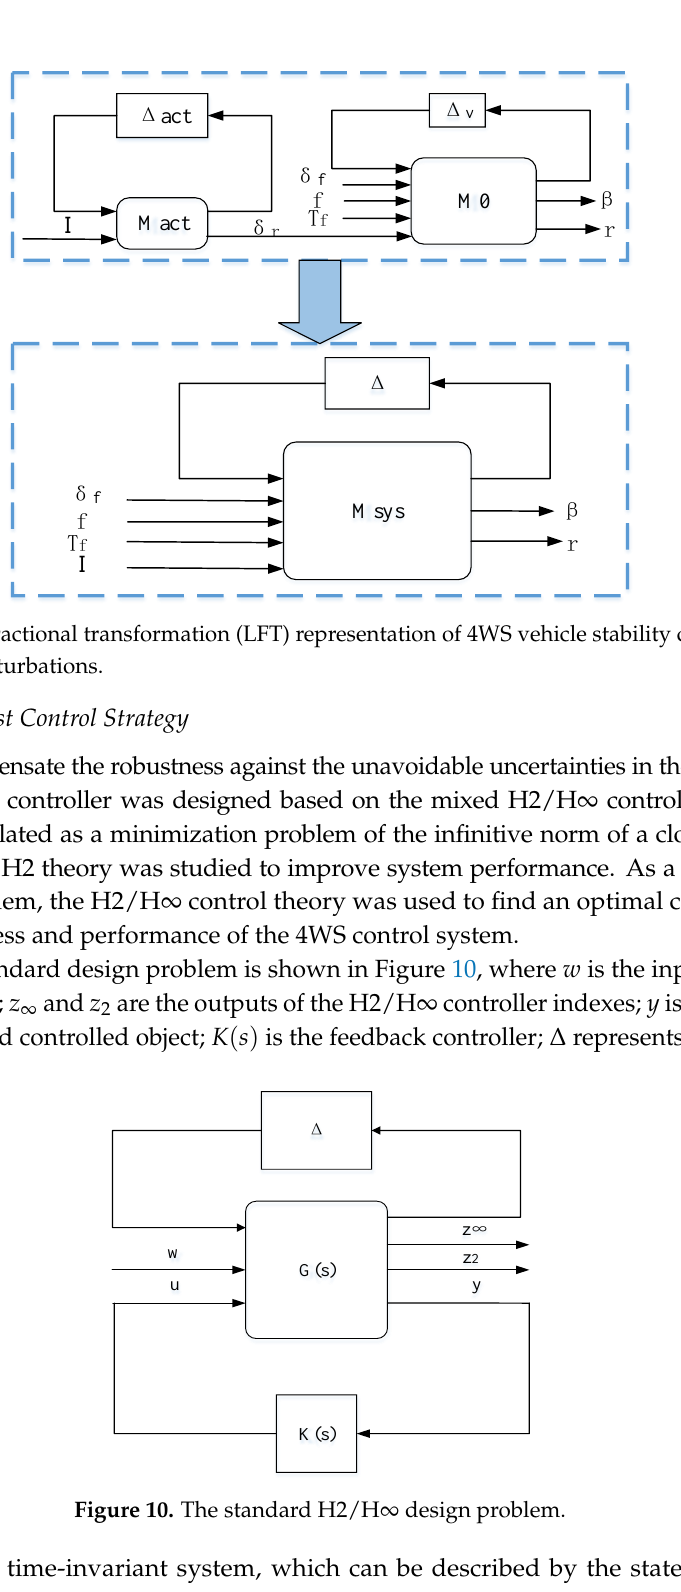
Figure 10. The s tandard H2/H∞ design problem .